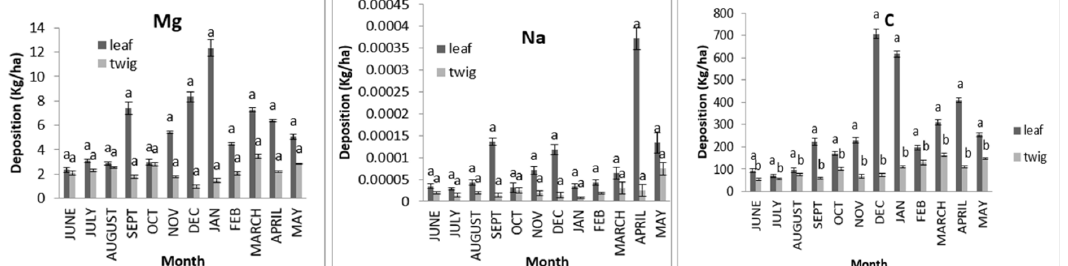
Figure 3b. Monthly nutrient deposition via litter fall in the bamboo stands in a Regenerating rainforest, Ile-Ife *Vertical bars of the same alphabet in a month are not significantly (P > 0.05 different using Duncan Multiple Range Test